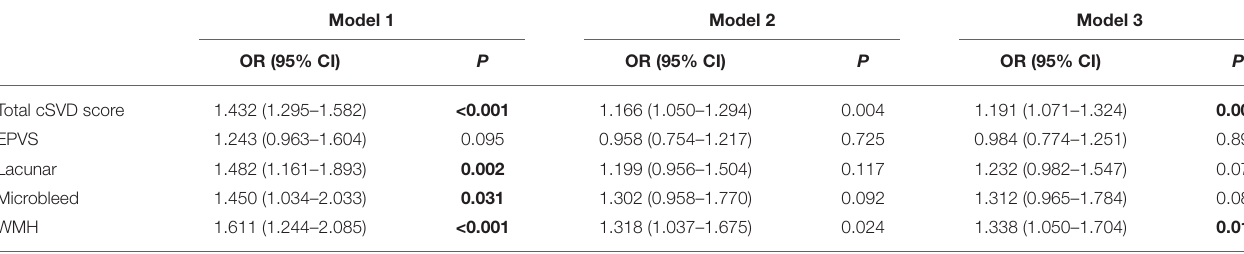
TABLE 3 | CSVD in relation to MTA by regression analysis.